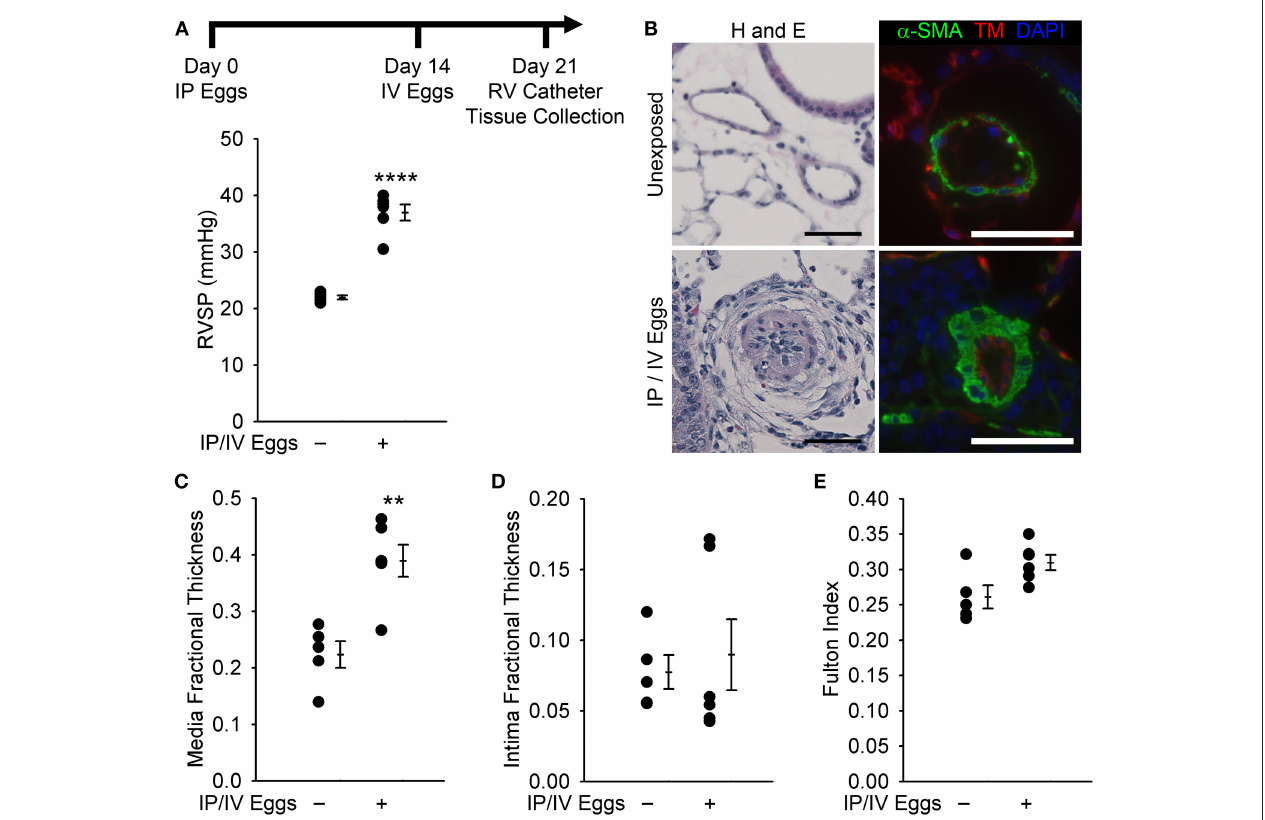
FIGURE 2 | Mice exposed to Schistosoma mansoni eggs develop pulmonary hypertension (PH) and vascular remodeling. (A) Mice intraperitoneally sensitized to S mansoni eggs followed by intravenous augmentation have an increase in right ventricular (RV) systolic pressure (RVSP; mean ± SE; n = 5–6 mice per group; rank-sum test, **** P < 0.001; this experiment was repeated 3 times with similar results). (B) Representative hematoxylin and eosin (H&E) and immunofluorescence staining for α -smooth muscle actin ( α -SMA) and thrombomodulin of unexposed and intraperitoneal/ intravenous egg–exposed mouse lungs (scale bars, 50 µ m). (C,D) Quantitative fractional thickness of the pulmonary vascular media and intima in unexposed and intraperitoneal/ intravenous egg–exposed mice (mean ± SE; n = 5–6 mice per group; rank-sum test, ** P < 0.01; P = 0.66 for intima thickness). (E) Fulton index [RV/(LV + S)] of unexposed and intraperitoneal/intravenous egg– exposed mice (mean ± SE; n = 5–6 mice per group; rank-sum test, P = 0.052) [Reprinted with permission from Graham et al.